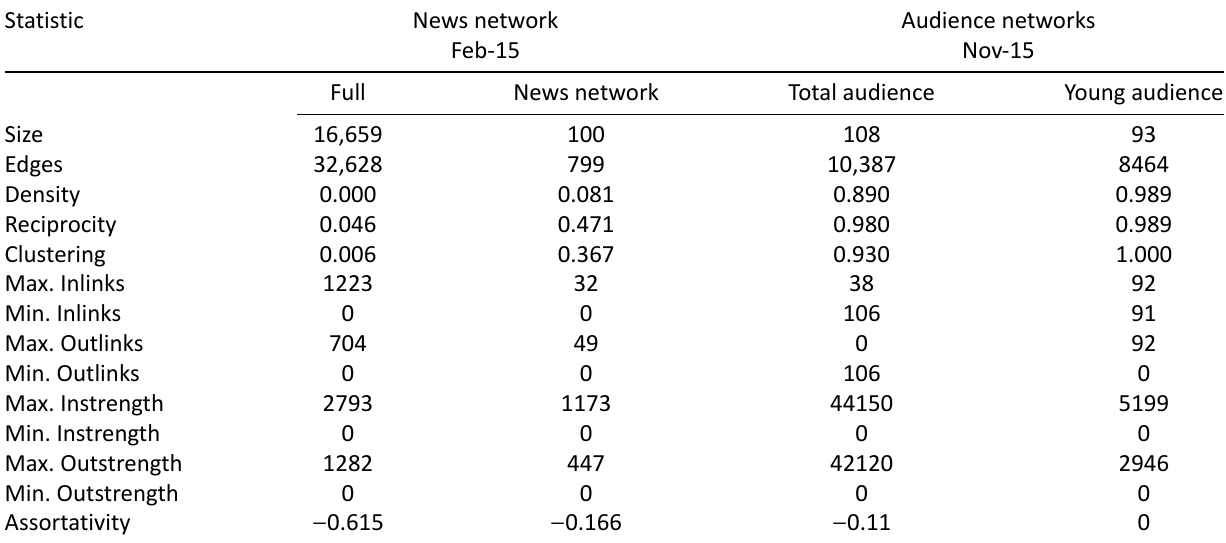
Table 1. Descriptive statistics of news and audience